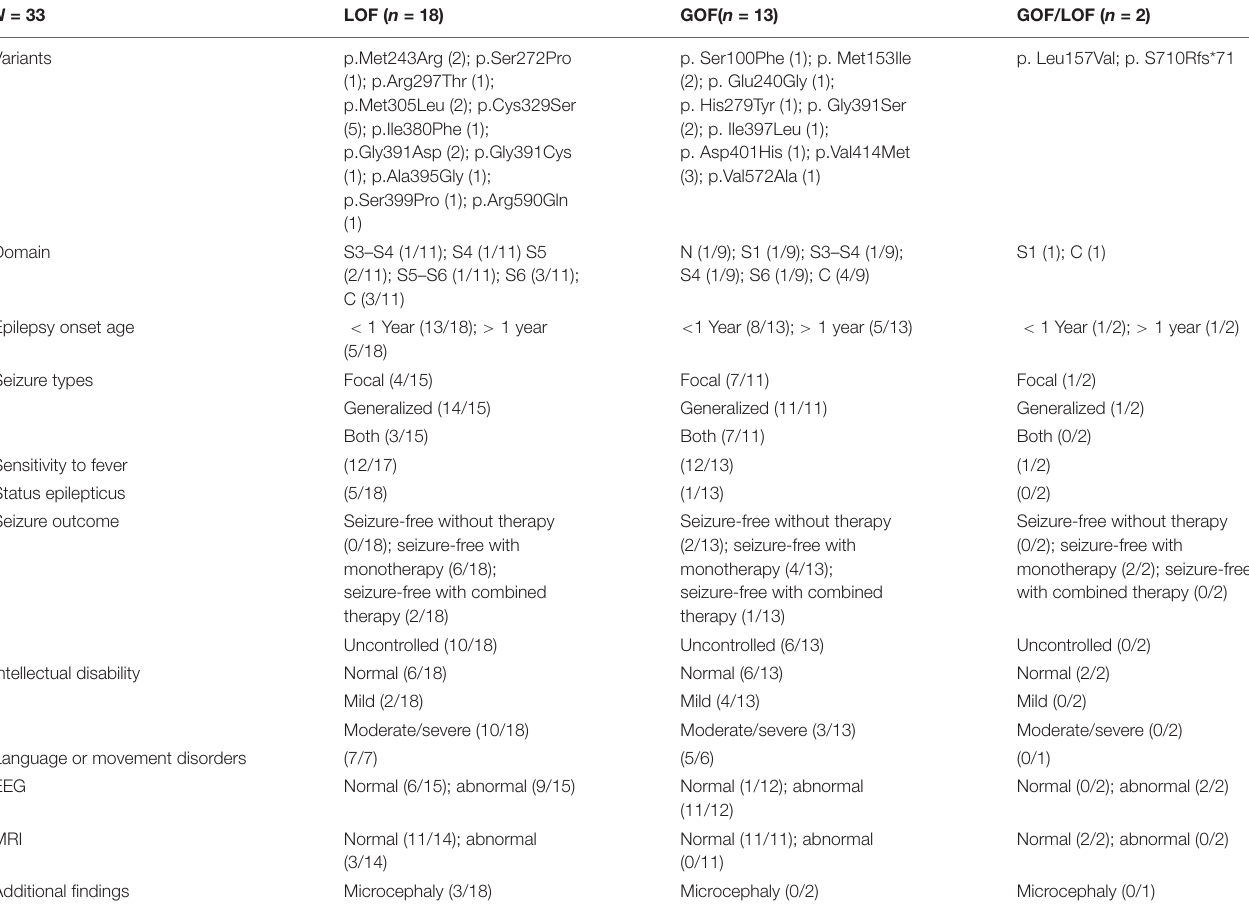
TABLE 1 | Phenotypic features of patients with different type of variants according to channel